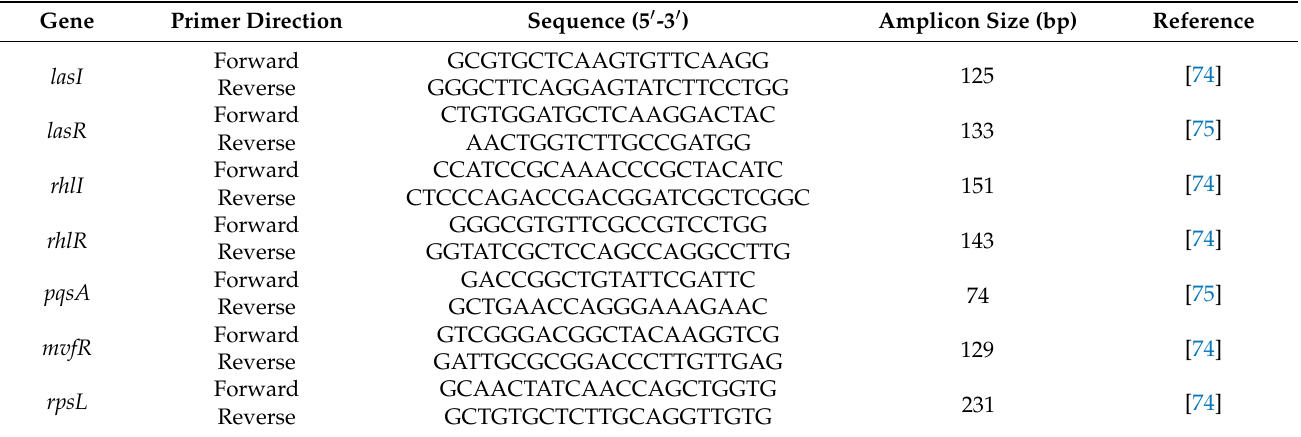
Table 4. Primers used for RT-qPCR